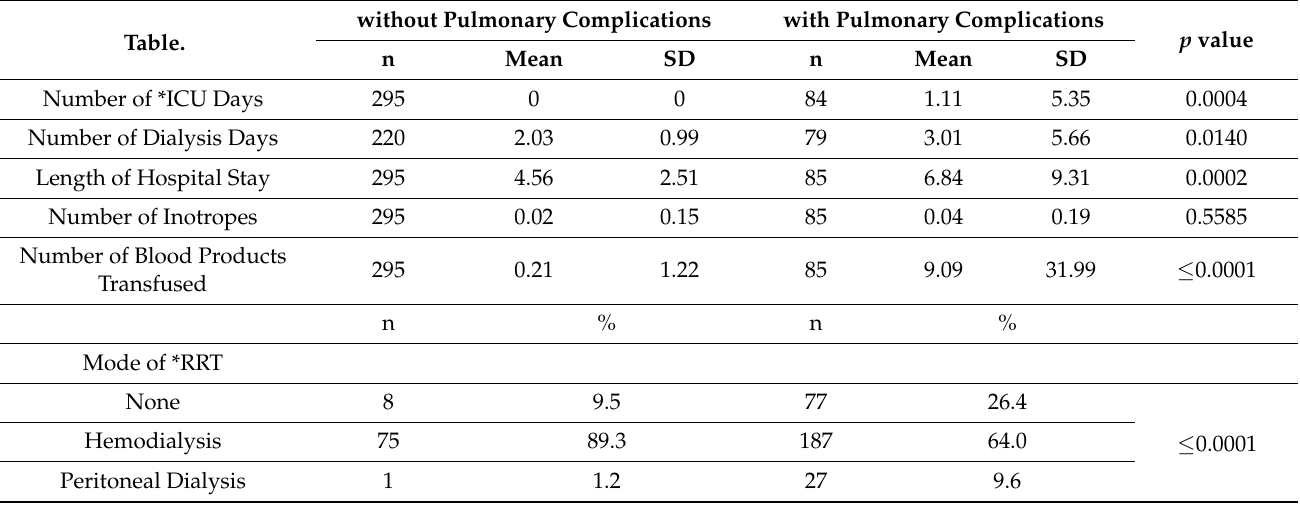
Table 4. Distribution of pulmonary outcome according to treatment-related data.